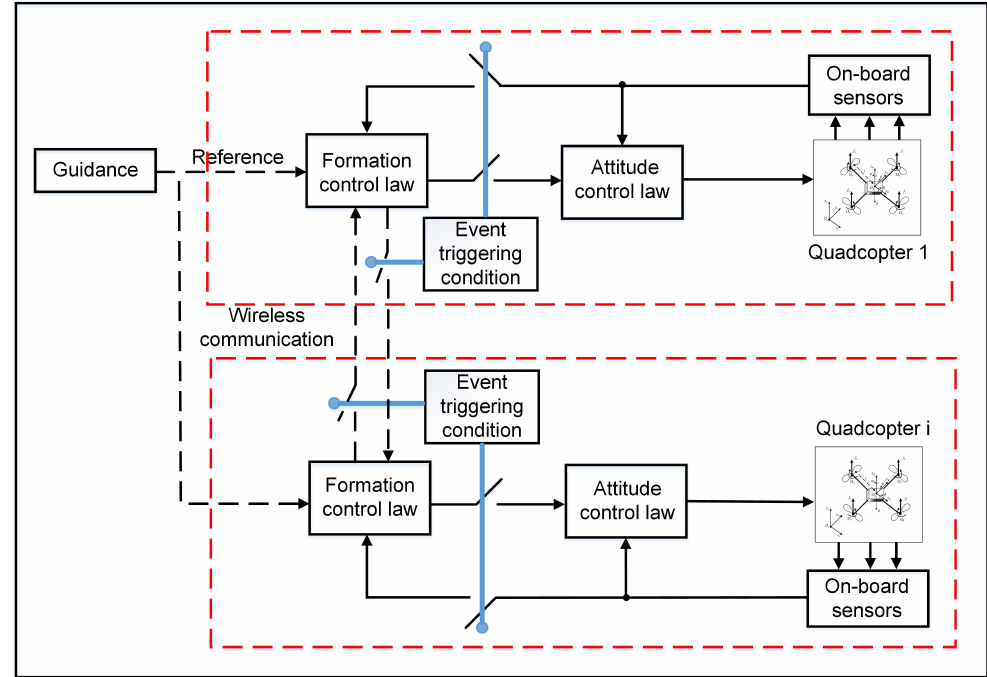
Figure 3. The control diagram of the multiple quadcopter system based on Robot Operating System